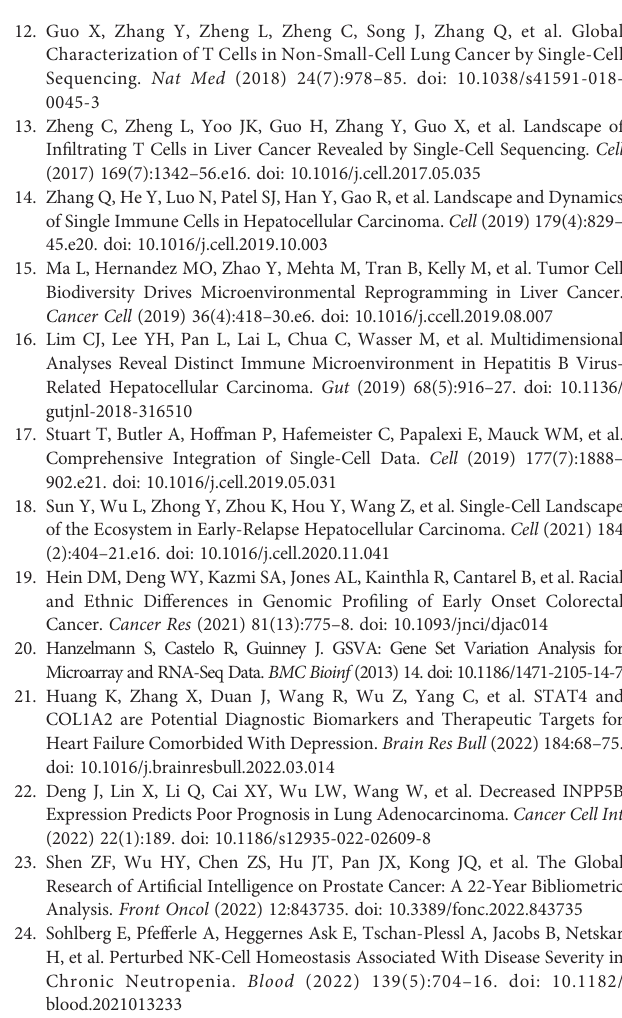
Supplementary Table 1 | The results of cell cross-talk from CellPhoneDB. Supplementary Table 2 |